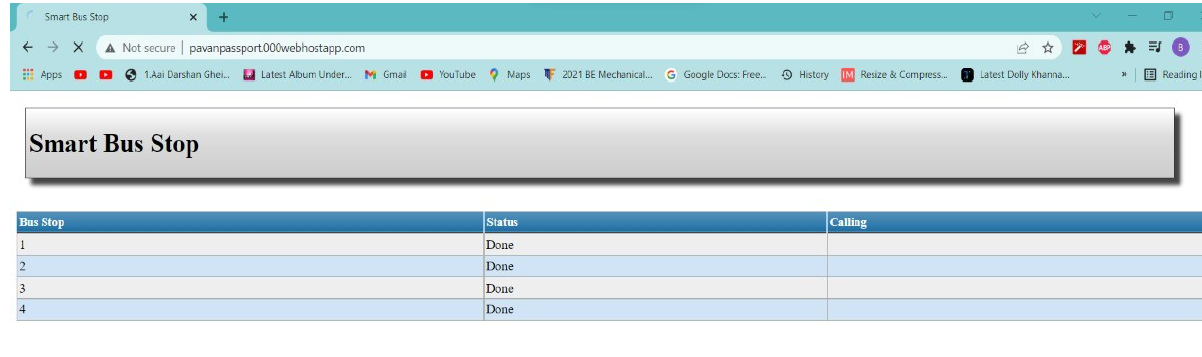
Figure 5. Web Page Showing the Information of the BUS and its BUS Stop